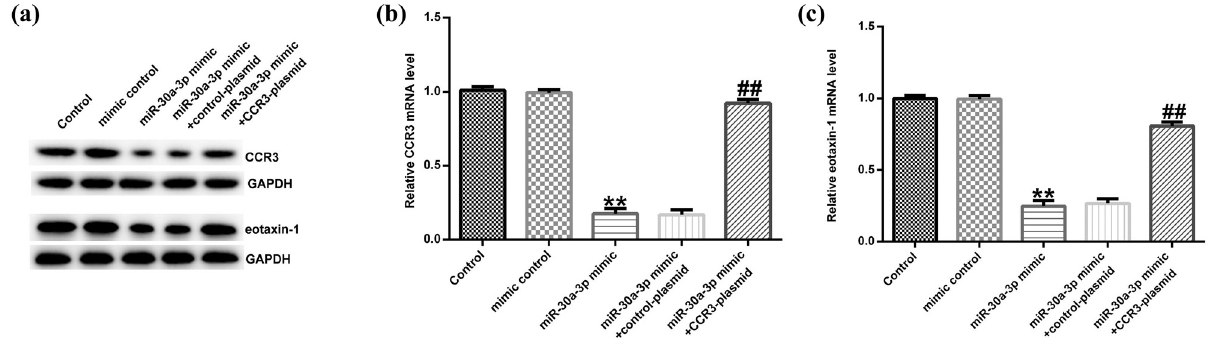
Figure 5: The e ff ect of miR - 30a - 3p mimic on the CCR3 signaling pathway in eosinophils. Eosinophils were transfected with miR - 30a - 3p mimic, mimic control, miR - 30a - 3p mimic + control - plasmid, or miR - 30a - 3p mimic + CCR3 - plasmid for 48 h. ( a ) The protein expression levels of CCR3 and eotaxin - 1 were determined using western blot assay. ( b and c ) CCR3 and eotaxin - 1 gene expression levels were determined using qRT - PCR. CCR3, CC chemokine